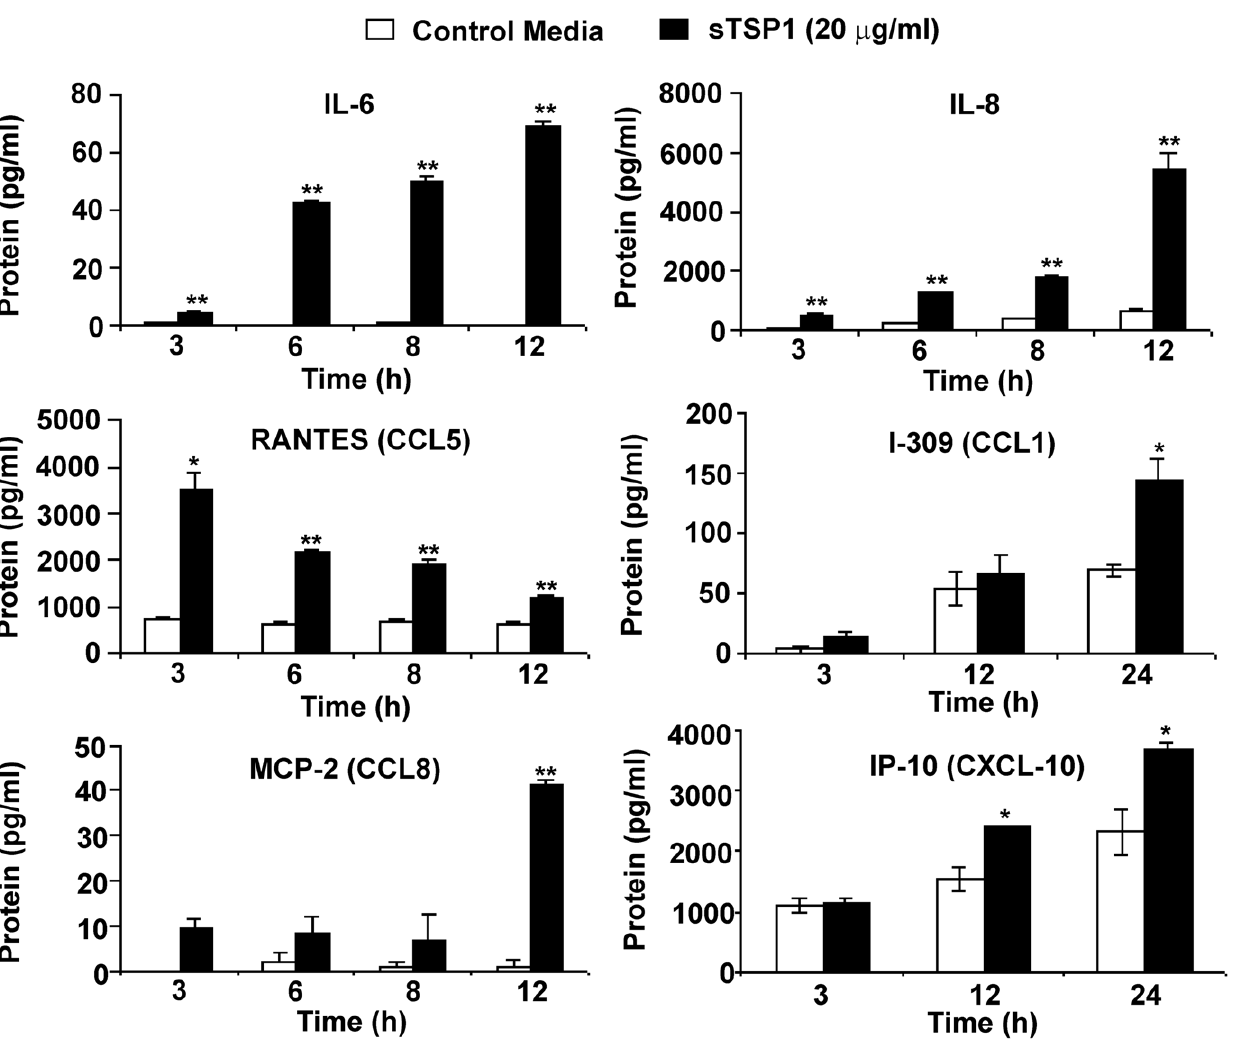
Figure 4. TSP1 enhances cytokine and chemokine production by human IFN- c -differentiated macrophages invitro . 1 6 10 6 IFN- c - differentiated U937 cells/condition were incubated in the absence or the presence of soluble TSP1. At the indicated times the supernatants were harvested, and total IL-6, IL-8, RANTES, I-309, MCP-2 and IP-10 were determined using a Multiplexed ELISA array. Bars, mean 6 SD, are representative of at least four different experiments. *indicates p , 0.05; **indicates p , 0.001.